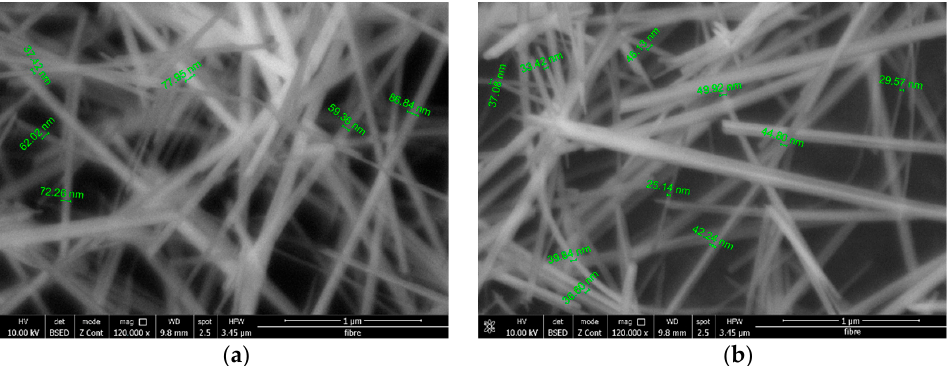
Figure 7. SEM micrographs of nanowires were obtained on the brown α -MnO 2 ( a ) and the black α -MnO 2 ( b ).